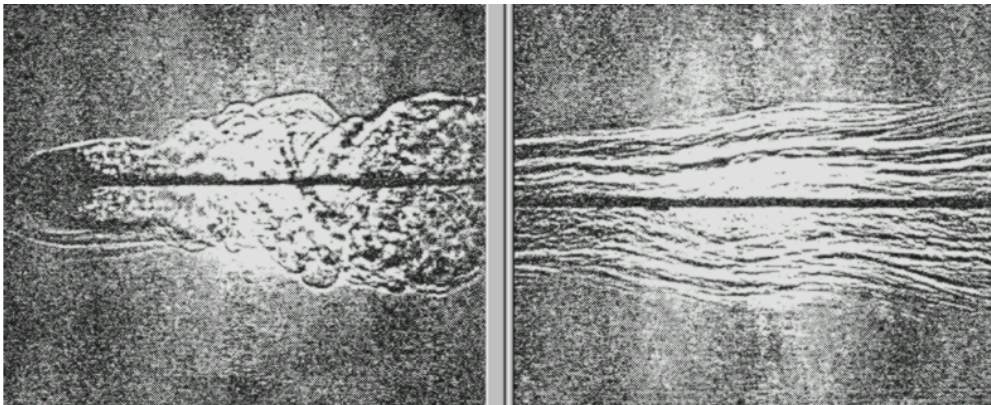
Fig. 7. Photographic images of turbulence generated by a flow around an object (Pao, 1968). The left-hand panel refers to the flow close to the object, and is clearly fairly isotropic at the smaller scales. The right panel shows the flow further downstream, as the turbulence dies out, and stratification is clearly